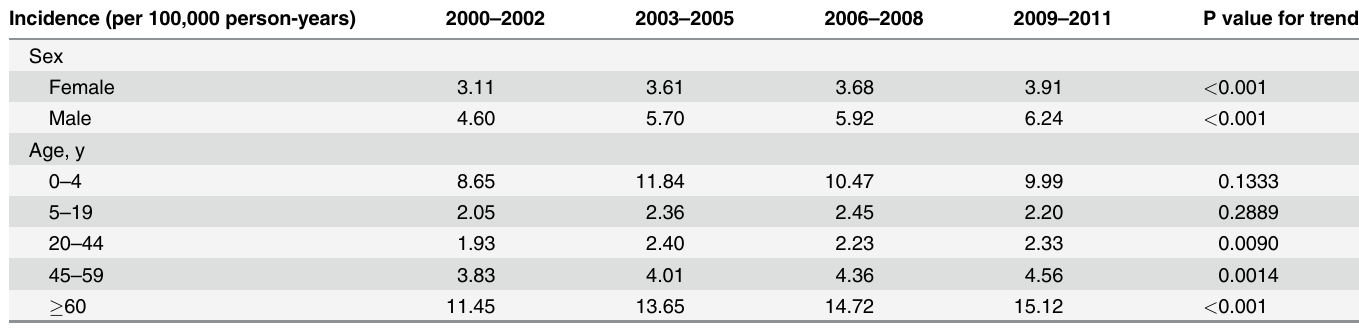
Table 2. Trend of the incidences of patients with SE from 2000 – 2011 by both sexes and age groups. Incidence (per 100,000